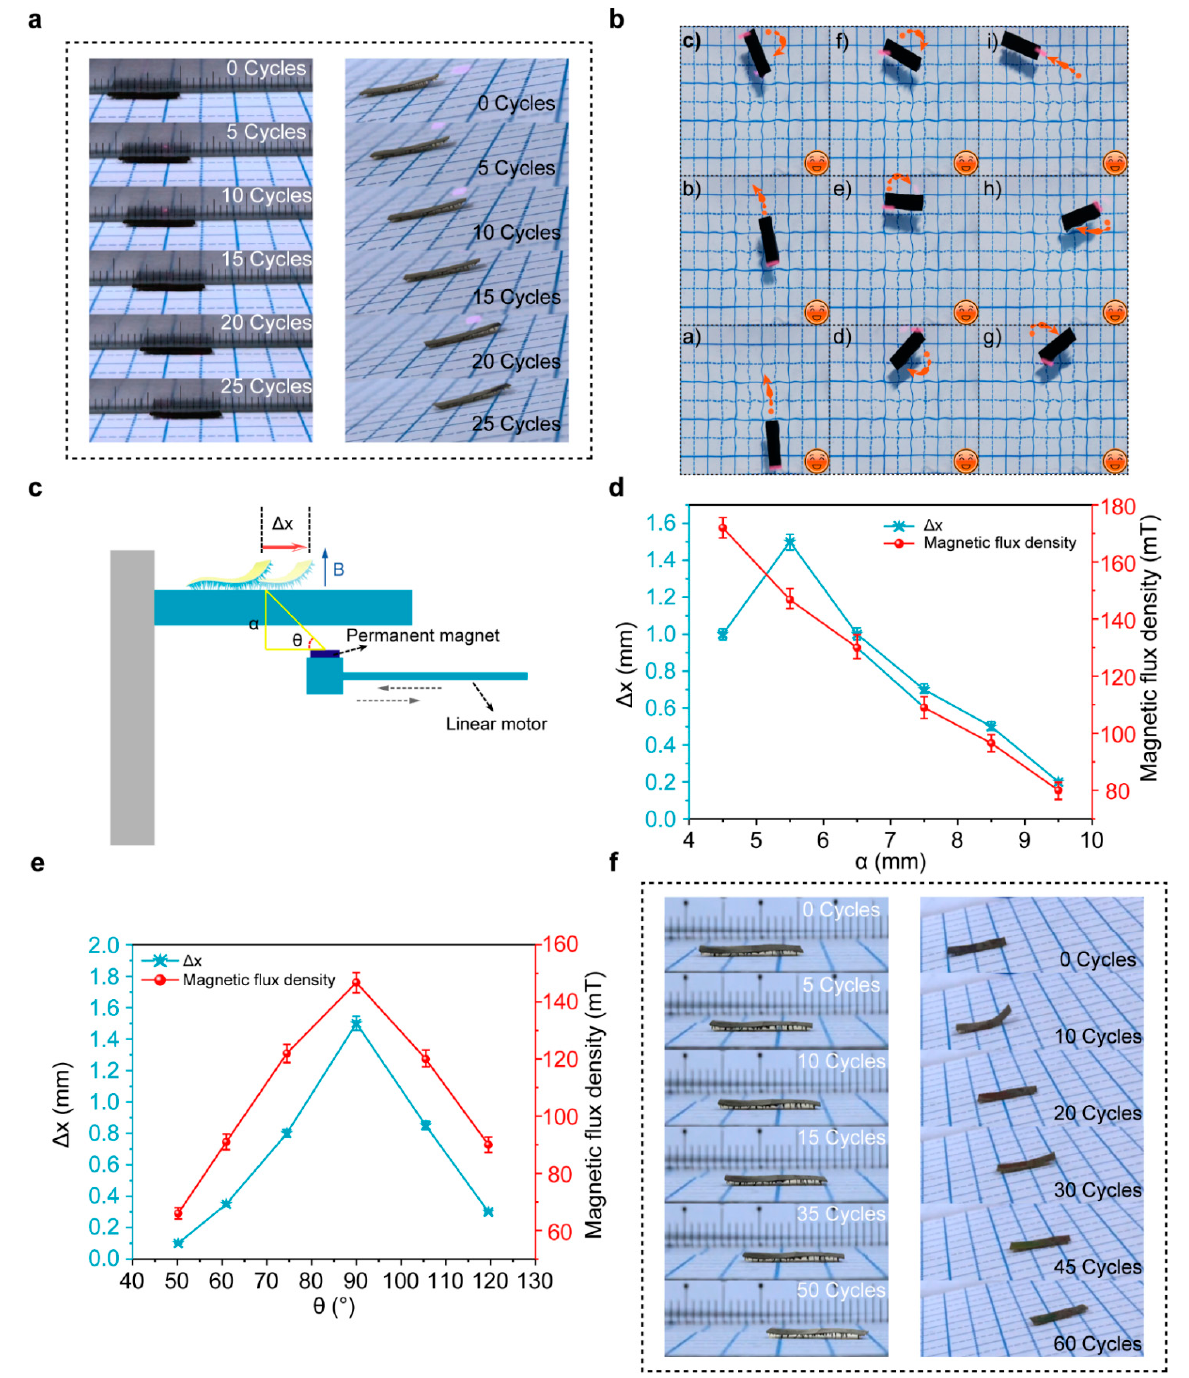
Figure 3. Fundamental characteristic of the multi-legged soft robot. ( a ) The light-driven locomotion of the millirobot moving forward on the plain ( left ) and climbing an 11° rope ( right ). ( b ) Swimming on the surface of the water under NIR light stimulus. ( c ) Schematic drawing for stimulating the soft robot in the magnetic-induced mode. ( d ) Vertical distance ( α ) between the robot and magnet dependence of the x -axis spatial displacement ( Δ x) of our millirobot in a primary circulation and the corresponding effective magnetic flux density. ( e ) Angle ( θ ) of the magnetic flux density to provoke the robot determined the x -axis spatial displacement and corresponding effective magnetic flux density. ( f ) Magnetically driven motion of the robot walking on a plane ( left ) and climbing a 15° slope ( right ).